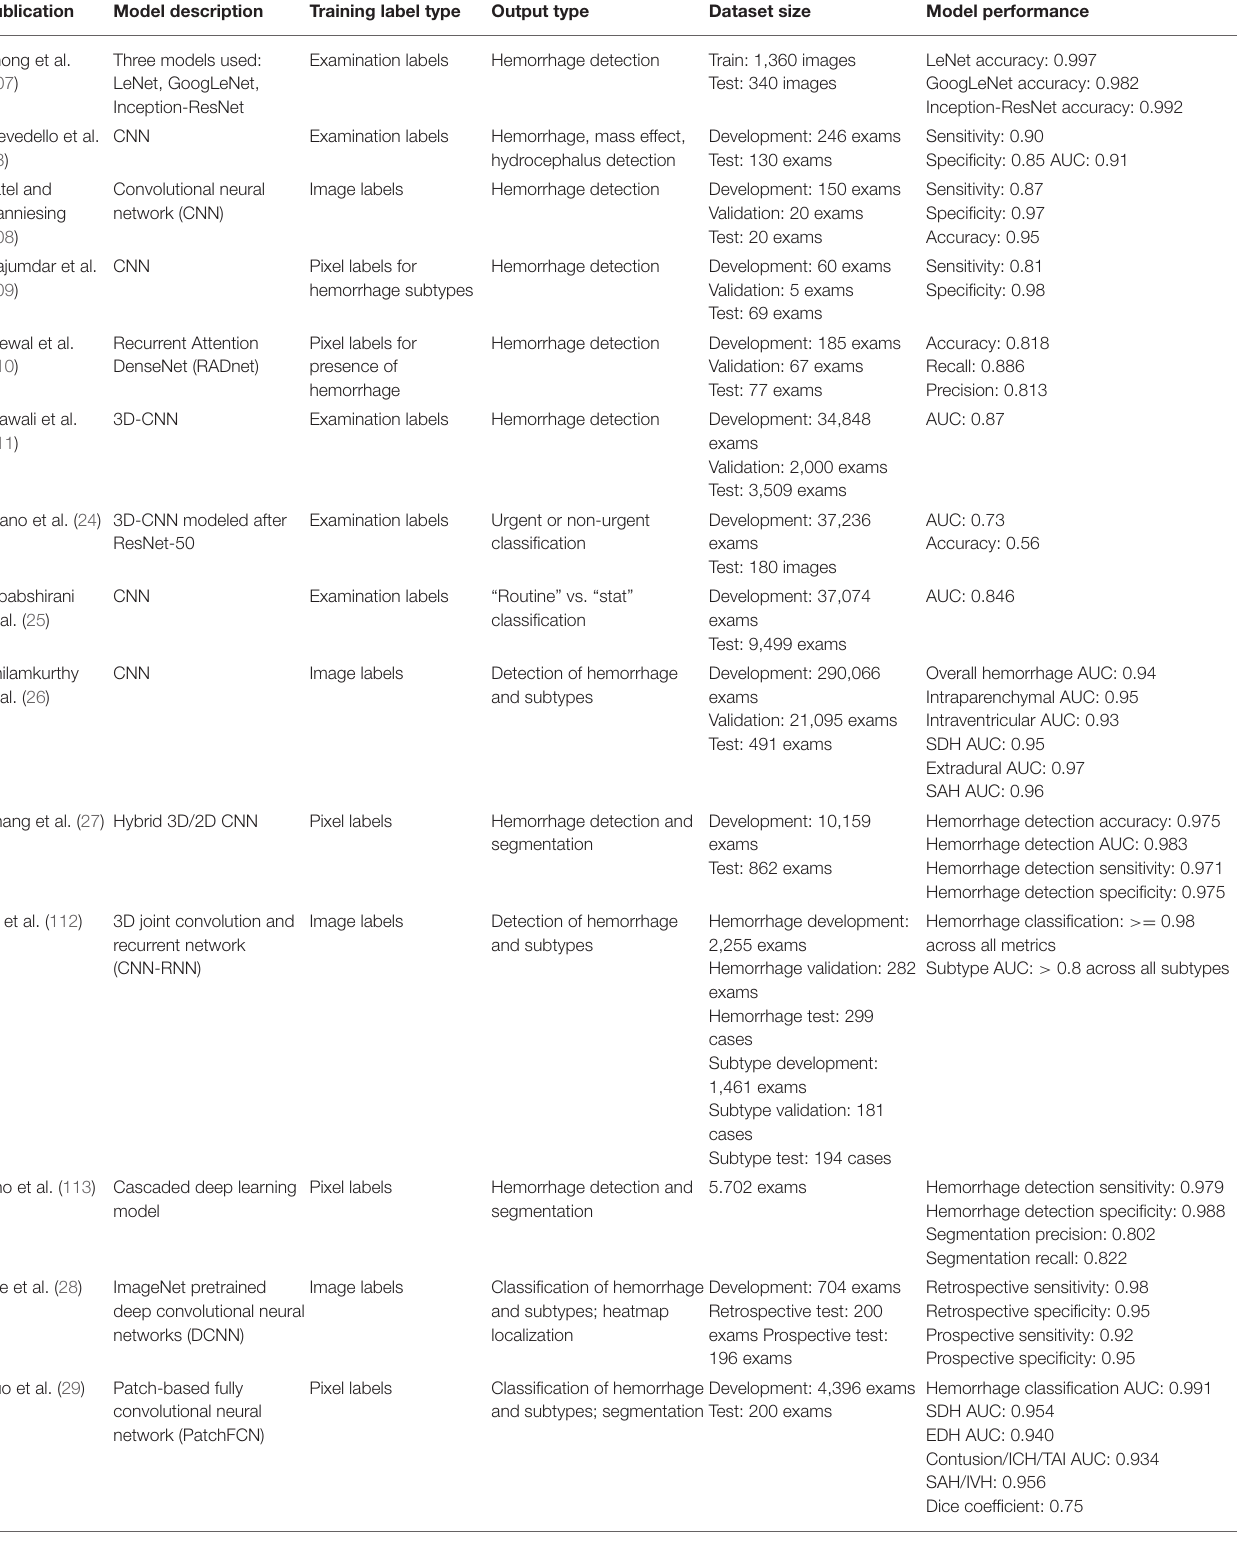
TABLE 1 | Deep learning approaches for intracranial hemorrhage detection and segmentation on head